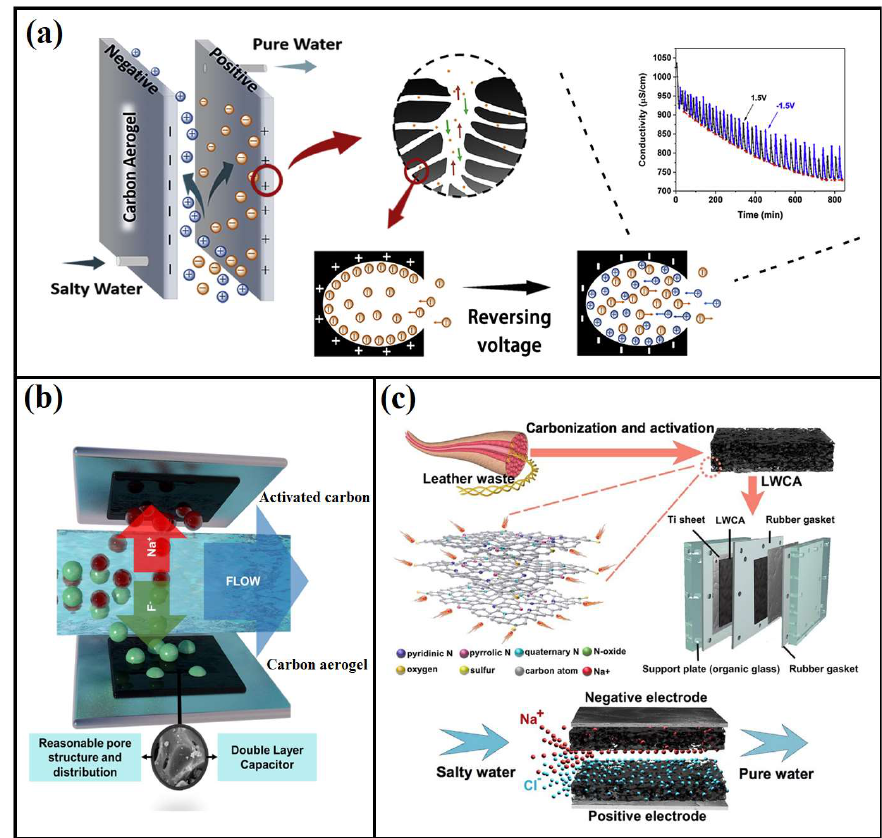
Figure 6. Schematic illustration of carbon aerogels for water deionization; ( a ) nanostructured carbon aerogel for capacitive deionization, adapted from Zhang et al. [99]. ( b ) Schematic diagram of carbon aerogel’s electrode and its defluorination, adapted from Zhang et al. [101]. ( c ) leather waste-based carbon aerogel using one-step pyrolysis for enhanced capacitive water deionization. Adapted from Liu et al.